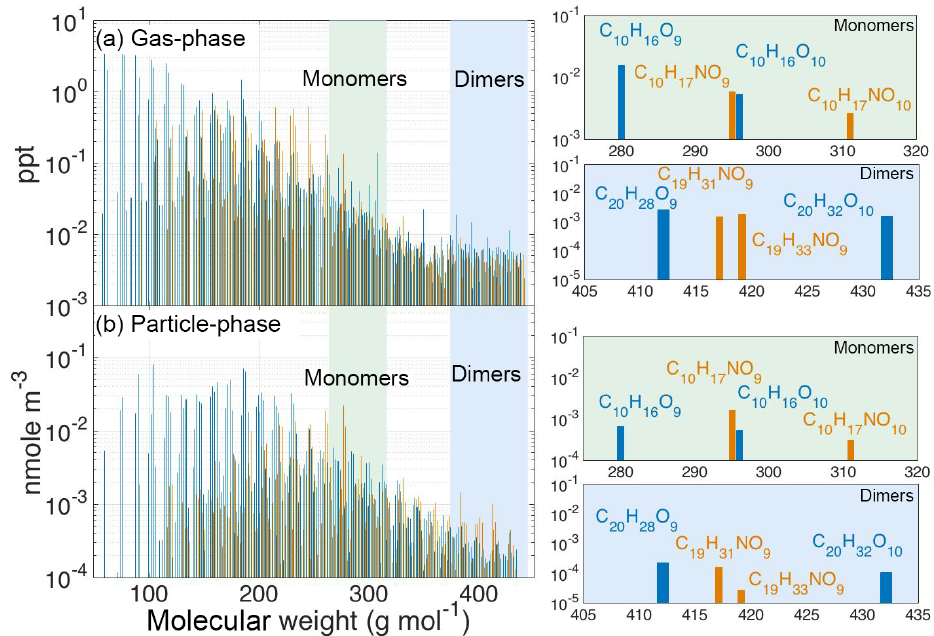
Figure 1. BAECC-median abundances of the organic nitrate (gold; ON = C x H y NO z ) and organic carbon (blue; OC = C x H y N 0 O z ) species in the (a) gas and (b) particle phases, plotted as a function of their molecular weights. The shaded green and blue areas in (a) and (b) highlight the molecular weight ranges of monoterpene-derived HOM monomers (nC = 10 and nO ≥ 7) and dimers (nC ≥ 16). Sub-panels on the right- hand side of (a) and (b) show the abundances of select monomers and dimers of the gas and particle phases, respectively.